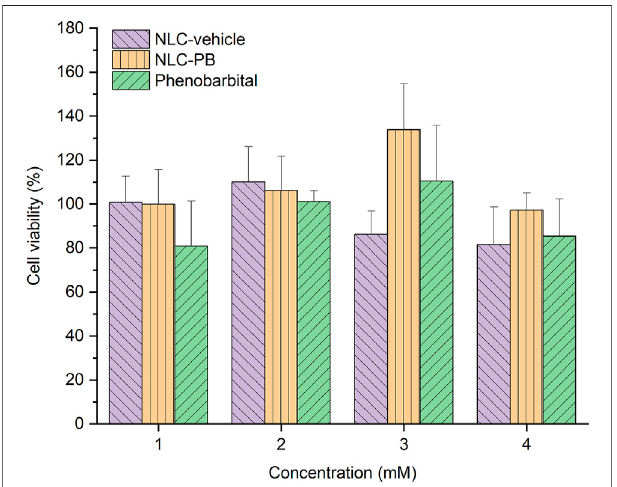
FIGURE 10 | In vivo evaluation of the anticonvulsant activity expressed as proportion (%) of mice protected at each post-dose time. Green bars represent positive control (free PB), orange bars the optimized formulation (NLC-PB), and violet bars the vehicle without drug (NLC-vehicle). Both free PB and NLC-PB, were tested at a dose of 25